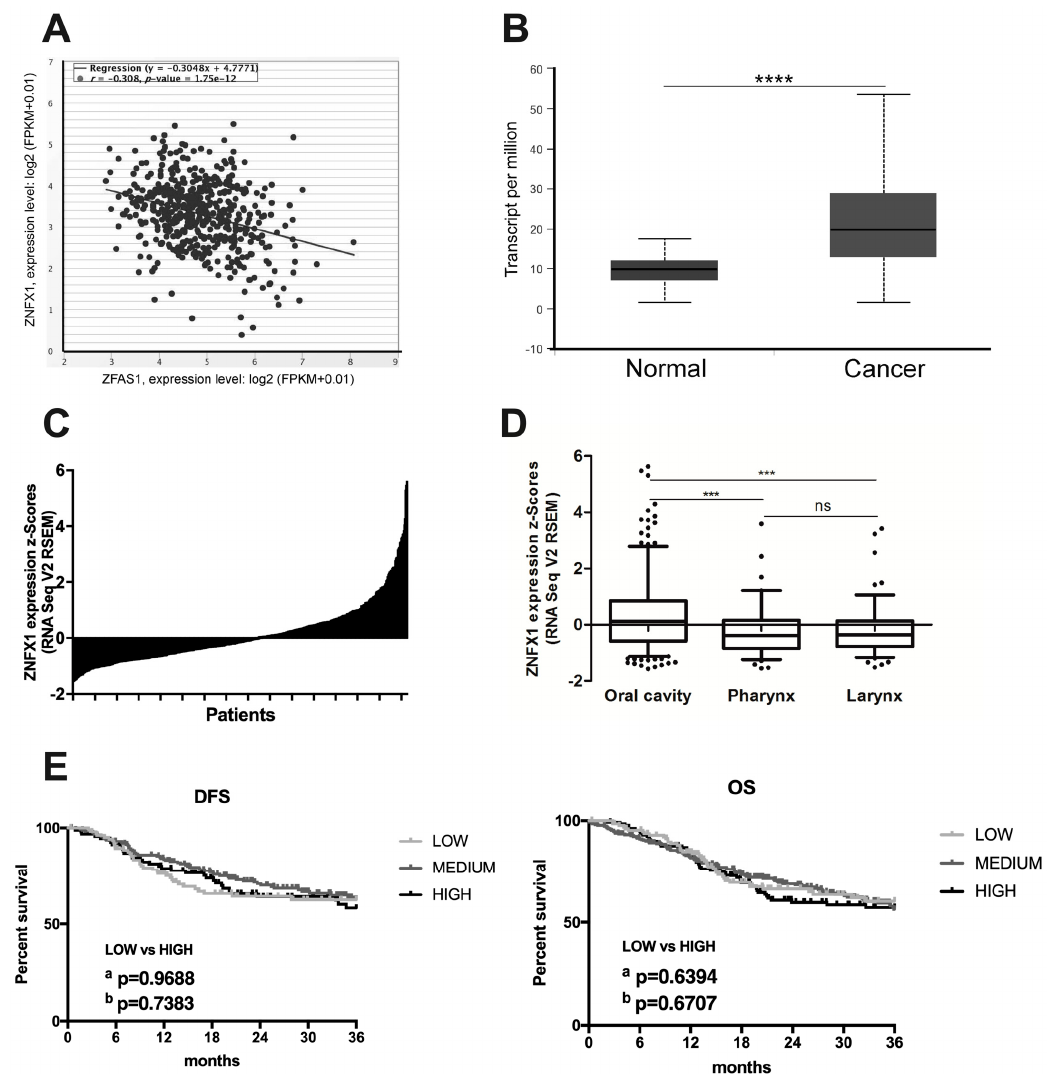
Figure 4. The expression level of ZNFX1 in HNSCC patients. ( A ) Correlation between ZNFX1 and ZFAS1 in HNSCC patients; Graph from StarBase v3.0 database, modified; ( B ) Expression in normal ( n = 44) and cancer ( n = 520) tissues; **** p < 0.0001; ( C ) Expression of ZNFX1 in cancer samples ( n = 520); ( D ) Expression depending on HNSCC localization ( n = 520); Graphs from UALCAN database, modified; Un-paired T-test; the graphs show mean of value presented as transcripts per million; and box and whiskers with 5–95 percentile, one-way ANOVA obtained using Dunn’s multiple comparisons tests; ns—no significant, *** p < 0.001; ( E ) DFS and OS in HNSCC patients with low ( n = 130) and high ( n = 130) expression levels of ZNFX1 ; a—Log-rank (Mantel-Cox) test, b—Gehan-Breslow-Wilcoxon test; p < 0.05 considered as